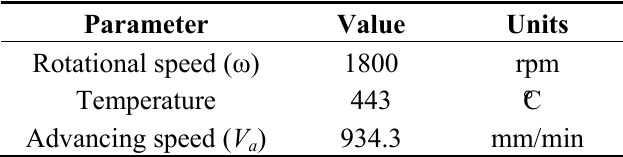
Table 2. Optimization results.